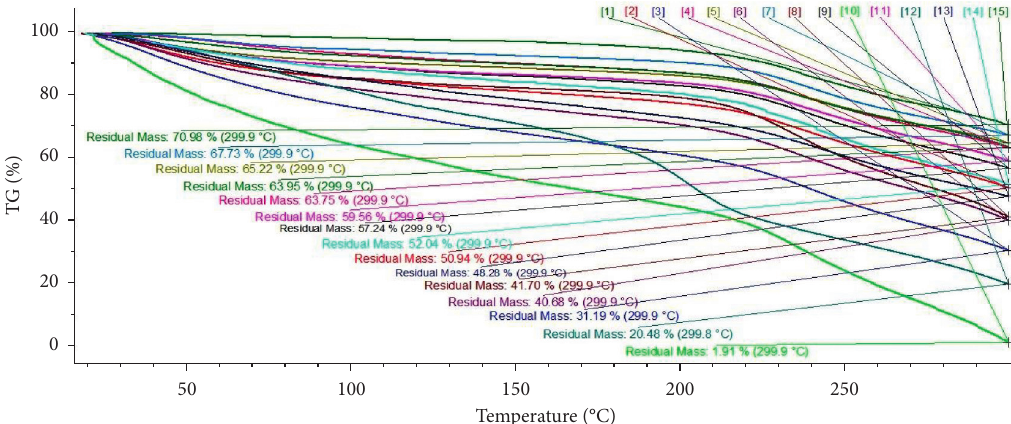
Figure 3: Combined thermogravimetric curves of onion skin powder of fifteen cultivars exploring gradual mass loss:1, Agrifound Dark Red; 2, Agrifound Light Red; 3, Arka Kirthiman; 4, Bhima Kiran; 5, Bhima Shakti; 6, Bhima Shubhra; 7, Hissar-2; 8, Hissar-3; 9, NHRDF Red; 10, Phursungi Local; 11, Pusa Madhavi; 12, Pusa Red; 13, Pusa Riddhi; 14, Sukhsagar; 15, Udaipur Local. Table 3: Maximum mass loss (with respect to the temperature) and residual mass of onion skin powder of fifteen cultivars. Cultivar